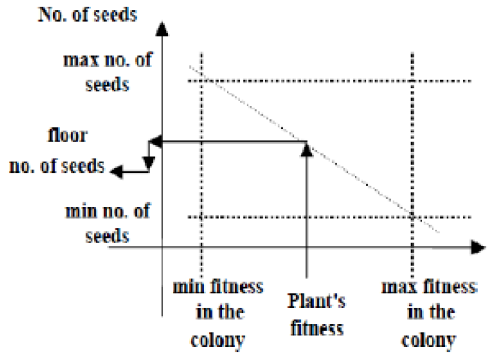
Figure 4. relationship between the number of seed and value of fitness function (Mehrabian and Lucas,